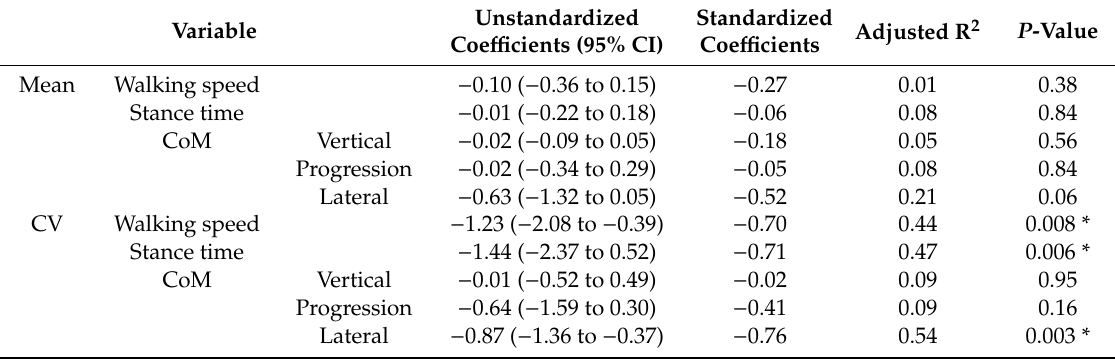
Table 2. Linear regression analysis results showing the e ff ects of values obtained without stimulation and changes in values due to stimulation. Variable